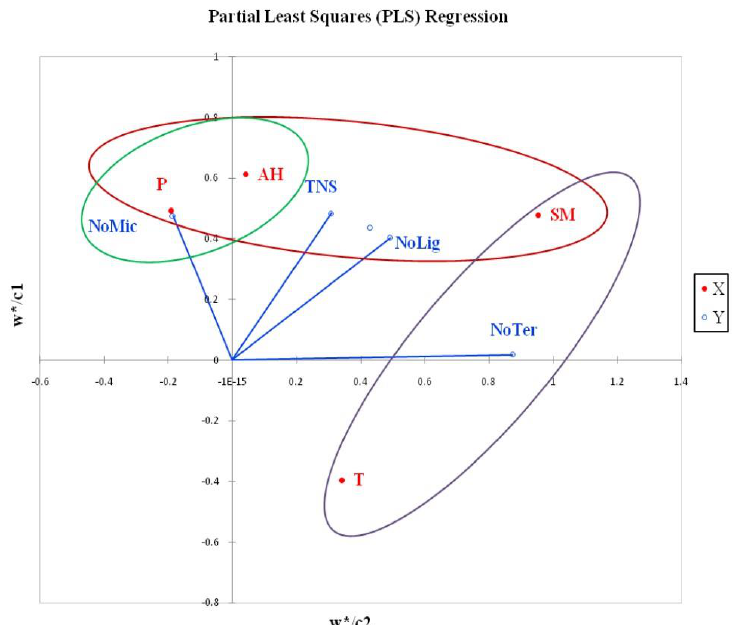
Figure 5. PLS analysis of the dependence of the macrofungal species richness on abiotic factors. Legend: independent variables (axis X): T − air temperature, P − mean monthly precipitation, AH − air humidity, SM − soil moisture; dependent variables (axis Y): TNS − total number of identified species, NoMik − number of mycorrhizal species, NoLig − number of lignicolous species, and NoTer − number of terricolous saprotrophs.